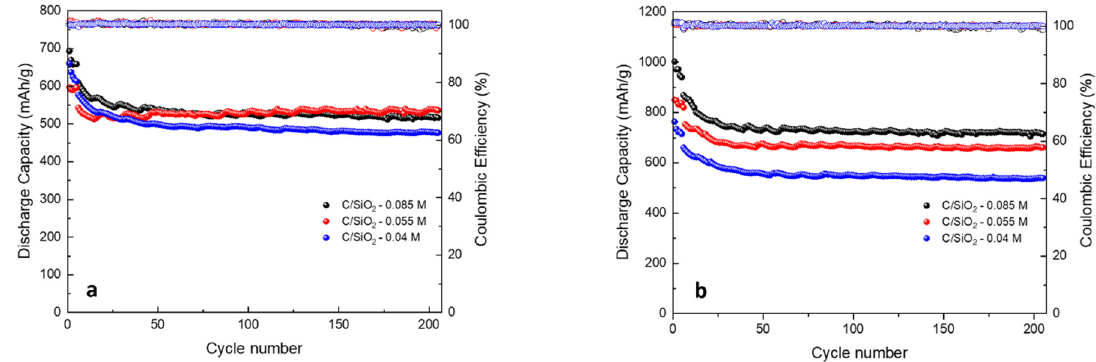
Figure 12. Cycling performance of ( a ) C/SiO 2 -0.04 M, C/SiO 2 -0.055 M, and C/SiO 2 -0.085 M, uncalendered electrodes and ( b ) C/SiO 2 -0.04 M, C/SiO 2 -0.055 M, and C/SiO 2 -0.085 M calendered electrodes, at 1C, 200 cycles.